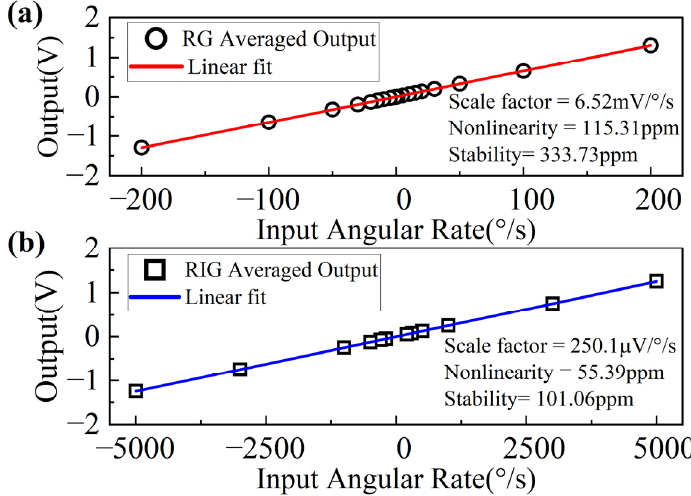
Figure 8. ( a ) RG and ( b ) RIG model scale factor fitting curves.